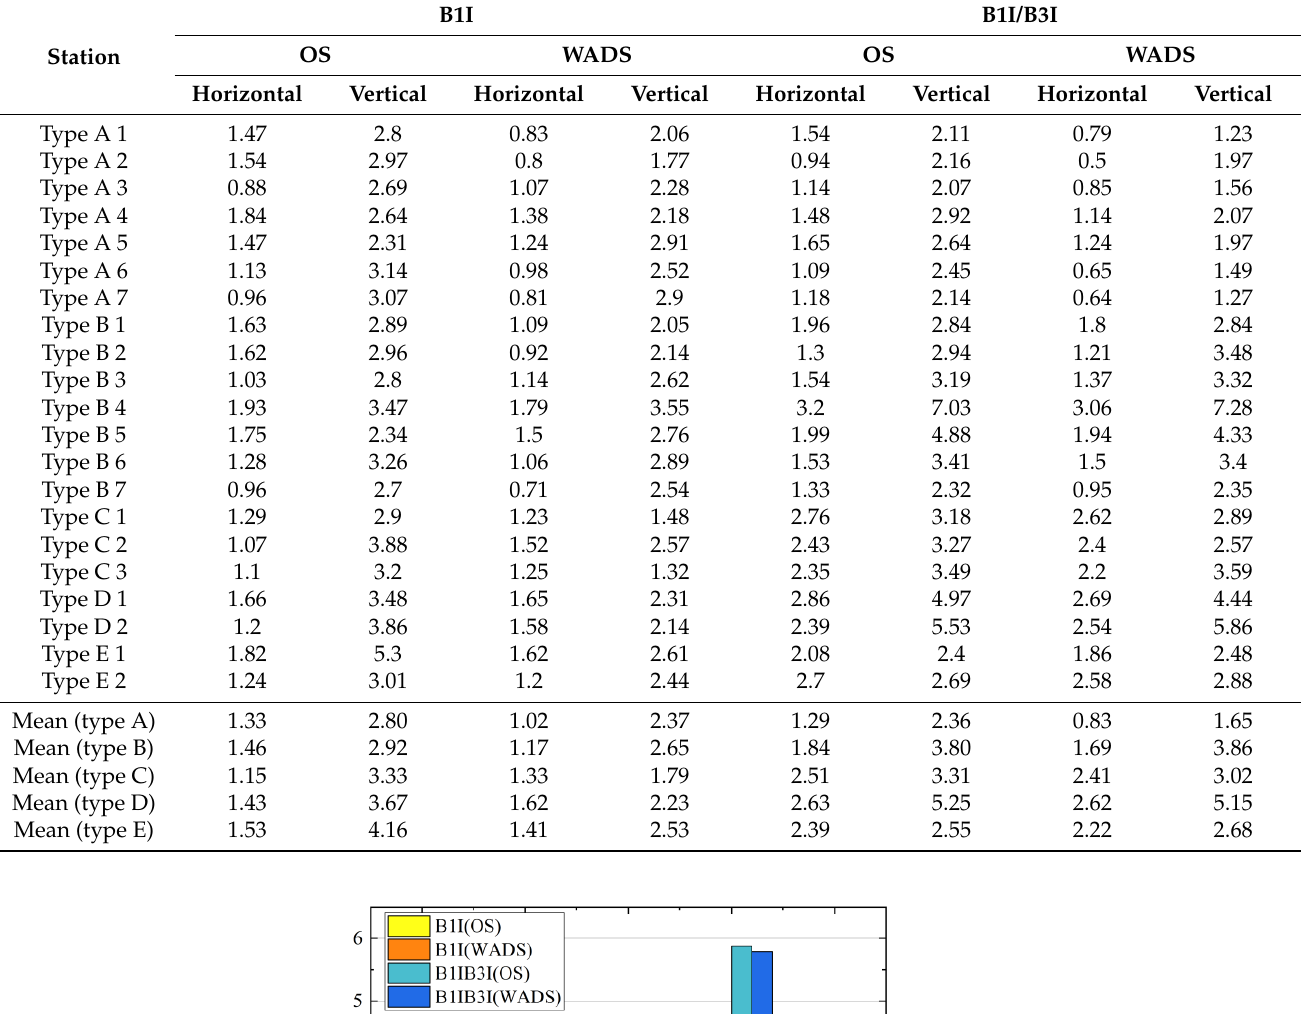
Table 5. The single- and dual-frequency positioning accuracy in the BDS OS and the WADS (unit: meter).